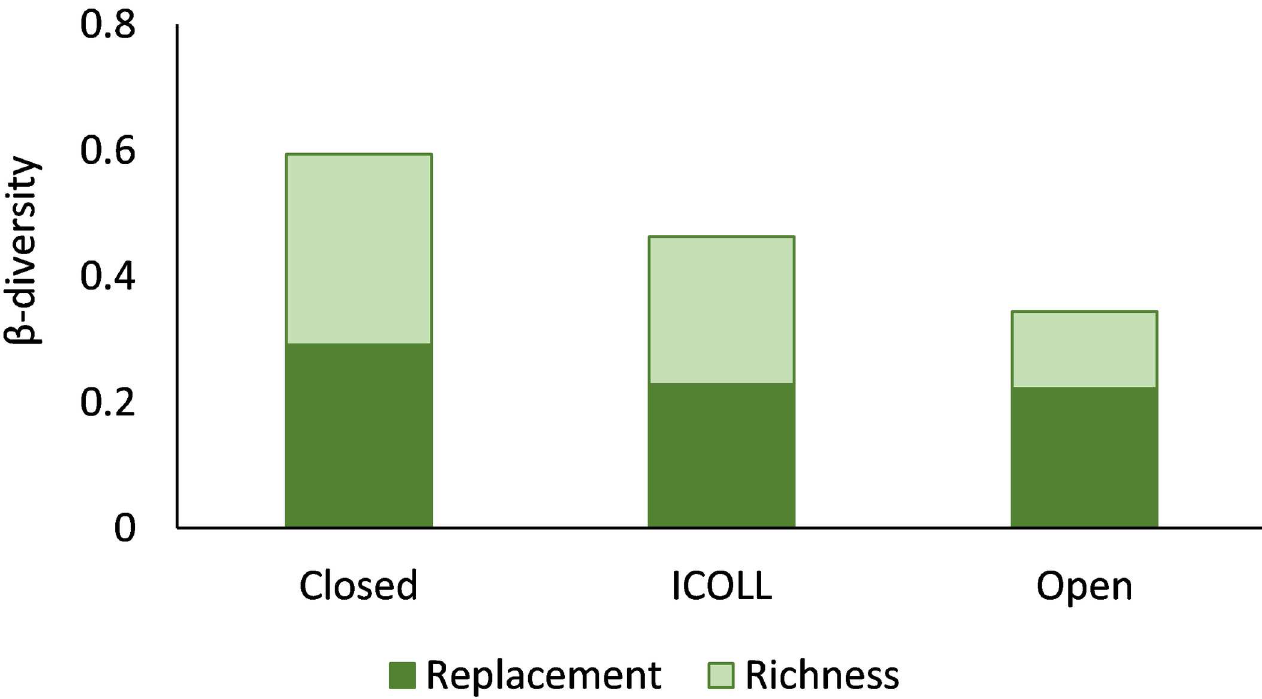
Fig 6. Nematode variation in genera composition (total mean β -diversity), contribution of replacement and richness differences (gray dots) and within in inner outer portions of lagoons (columns). Different letters indicatesignificantdifferences(p < 0.05)amonglagoontypes.